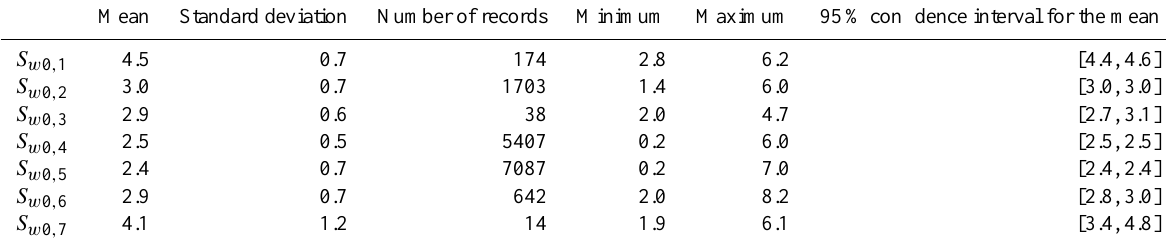
Table 8. Statistics of S w 0 ,i . Mean Standard deviation Number of records Minimum Maximum 95% confidence interval for the